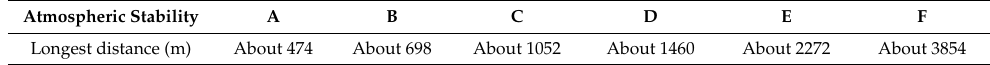
Table 12. The farthest distance when the NO 2 concentration decreased to 1 µ g/m 3 for a single puff. Atmospheric